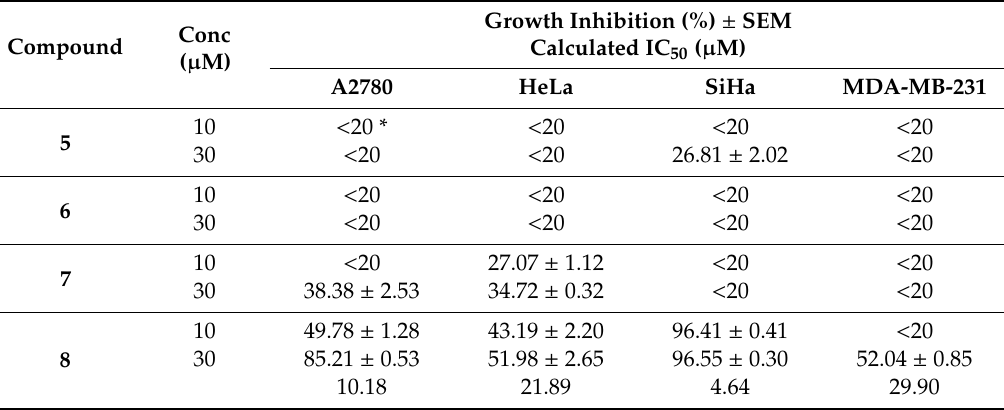
Table 3. Antiproliferative activities of the tested diterpene